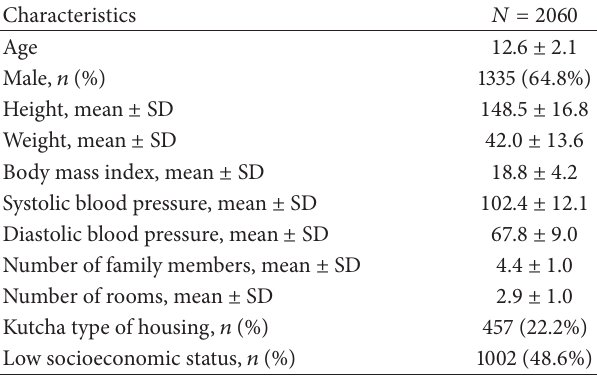
Table 1: Baseline characteristics of the study population.